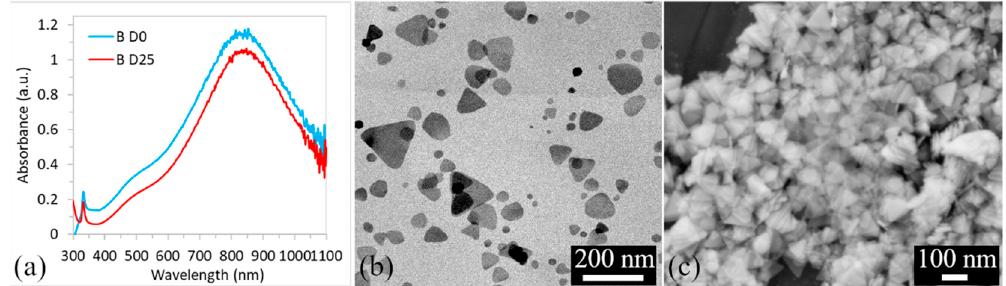
Figure 2. UV–vis spectra of the AgNPs colloids sample B for the day of synthesis (D0) and the 25th day (D25) ( a ); TEM microphotograph ( b ) and SEM ( c ) of AgNPs on D0.